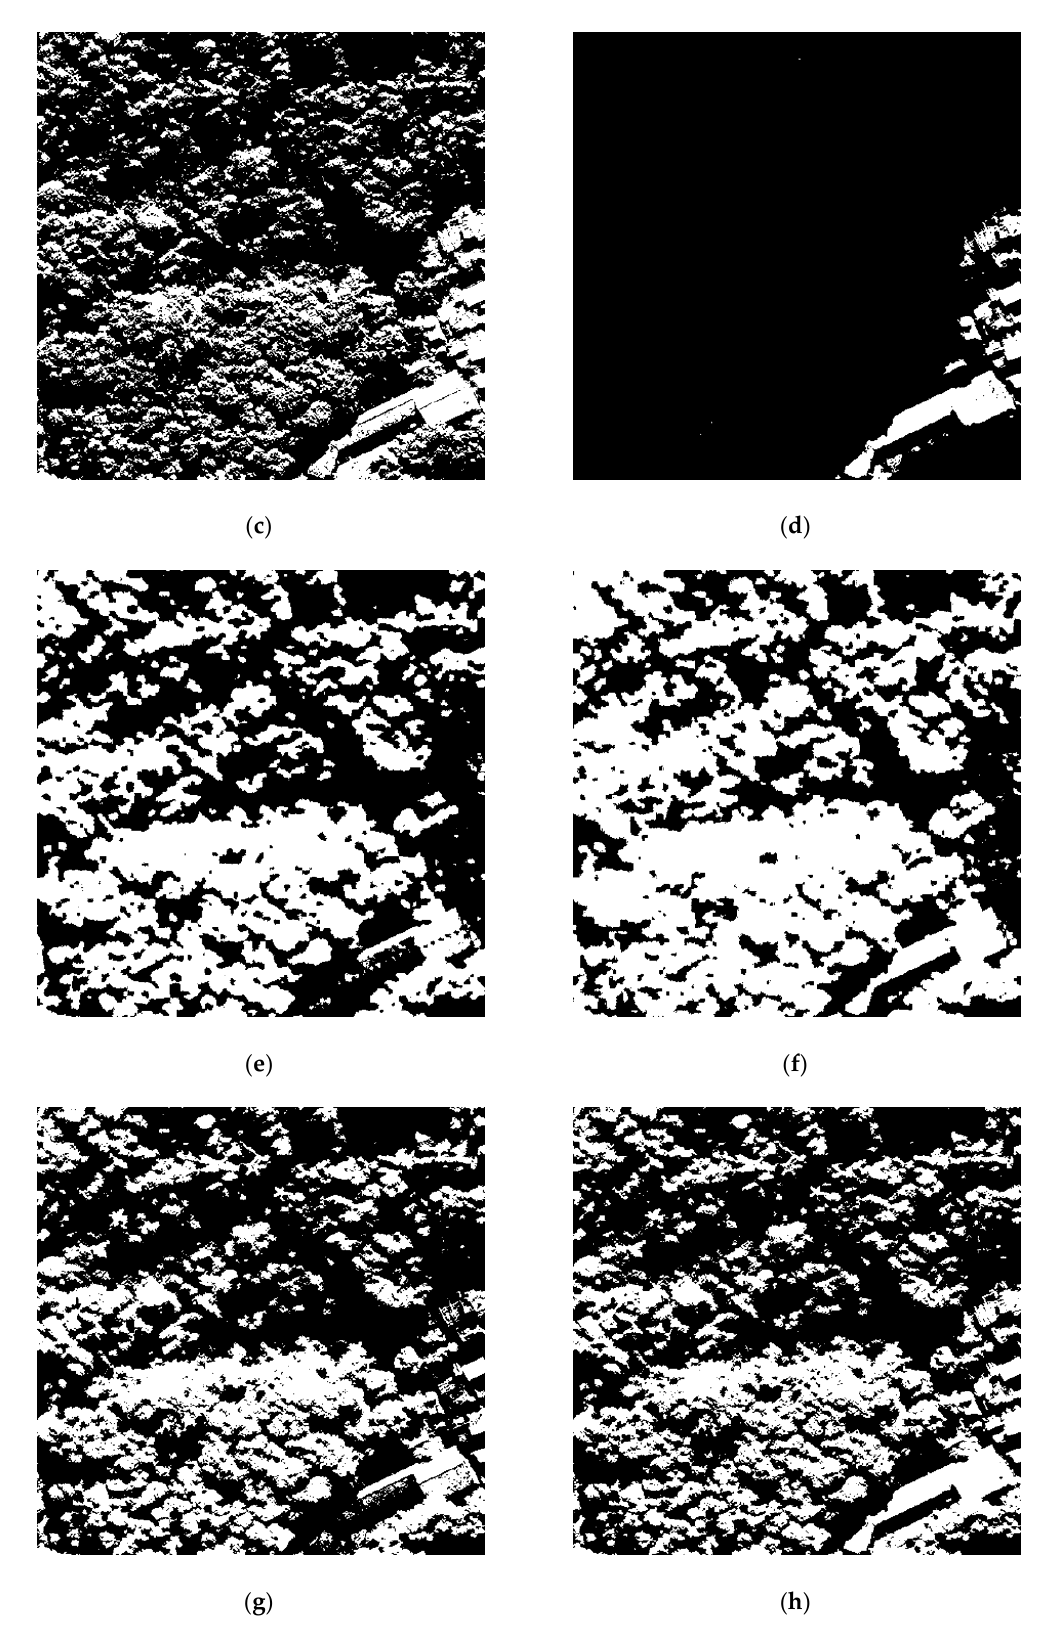
Figure 6. Test image B. ( a ) The original image. ( b ) The reference shadow image. ( c ) Shadow image by the SRI-based algorithm [11]. ( d ) Shadow image by the NSVDI-based algorithm [18]. ( e ) Shadow image by the MC3-based algorithm [20]. ( f ) Shadow image by the SI-based algorithm [14]. ( g ) Shadow image by the SDI-based algorithm [19]. ( h ) Shadow image by the developed MPSI-based